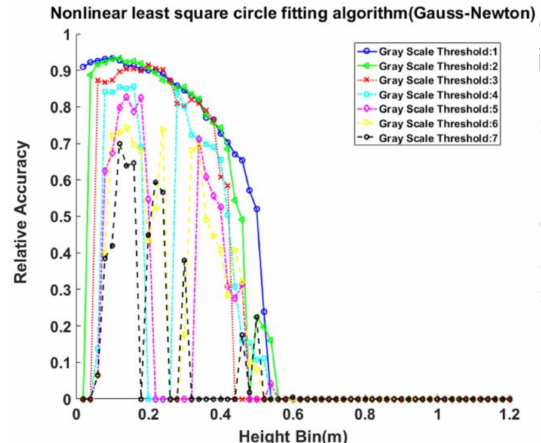
Figure 15. The relative accuracy of nonlinear least square circle fitting algorithm (Gauss-Newton) under different height bins and gray scale thresholds in single-scan mode of the